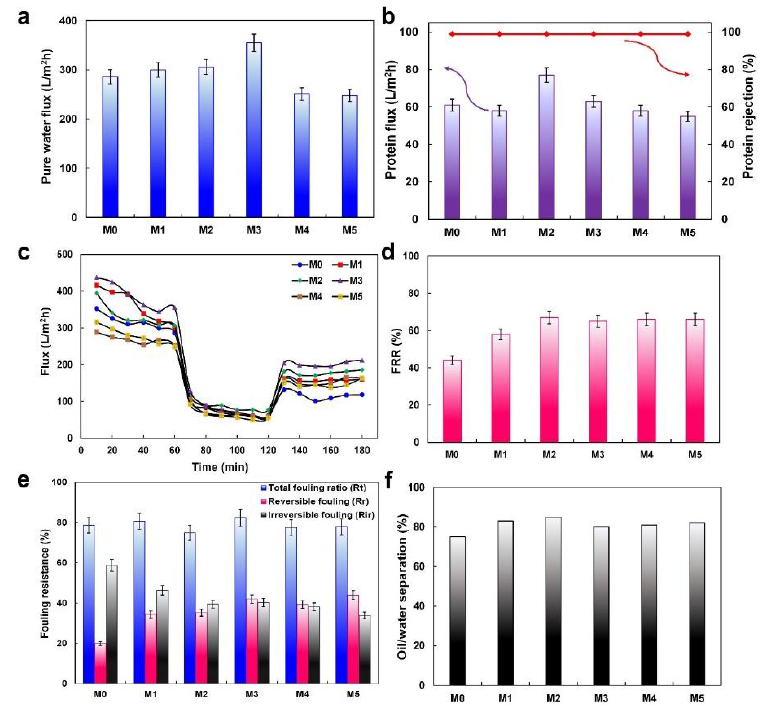
Figure 5. ( a ) The PWF, ( b ) flux and rejection of protein, ( c ) membrane flux against time. “The 1st, 2nd, and 3rd 60 min illustrate the PWF, protein solution flux, and the PWF after membrane cleaning, respectively”. ( d ) FRR%, ( e ) fouling ratio parameters, and ( f ) oil/water separation of different